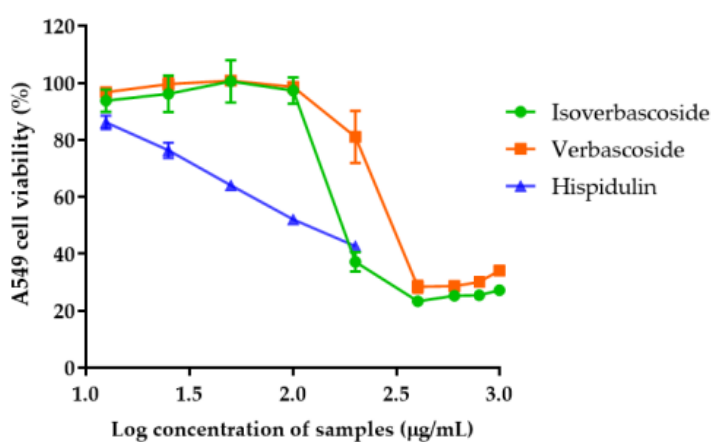
Antioxidants 2023 , 12 , x FOR PEER REVIEW Figure 3. A549 cell viability after incubation with ( A ) C. chinense leaf extract for 24, 48, and 72 h and ( B ) verbascoside, isoverbascoside, and hispidulin for 24 h. Data are shown as the mean ± SD ( n = 3).